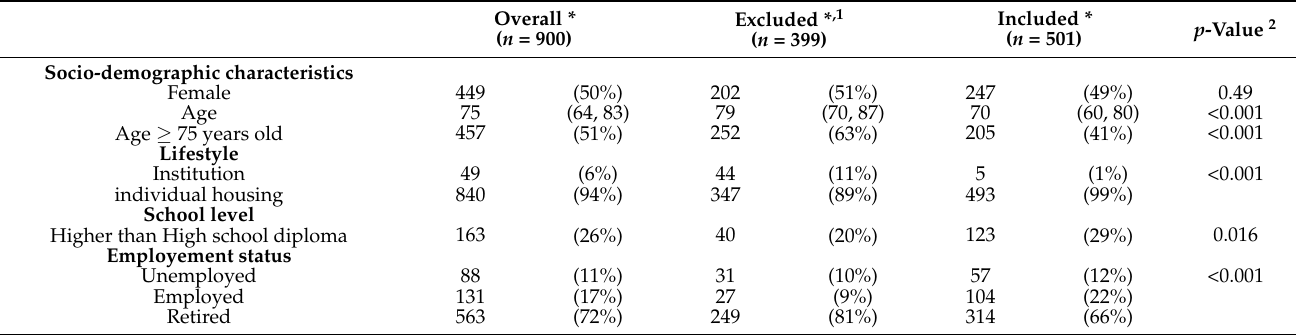
Table 1. Baseline characteristics of patients enrolled in the PARADISE study according to their inclusion in the QoL